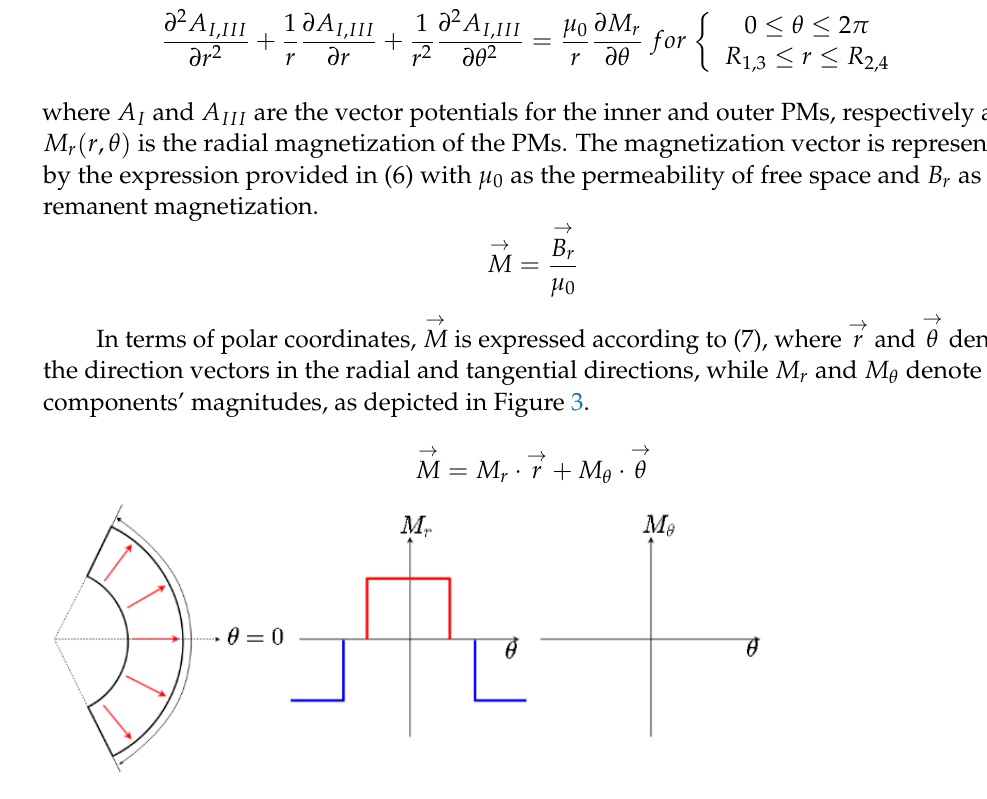
Figure 3. Magnetization components for radially magnetized PMs.